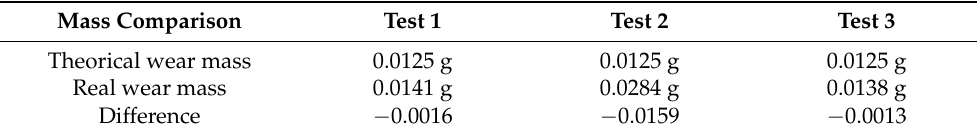
Table 7. Wear mass comparative.